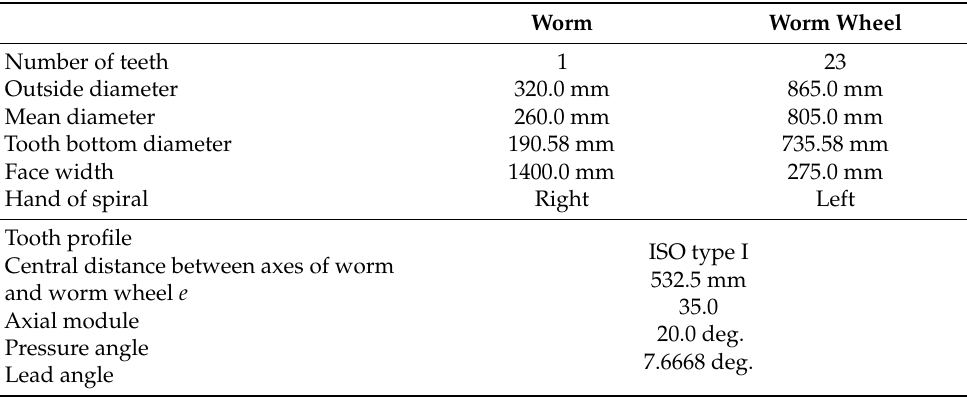
Table 1. Fundamental specifications of worm gear